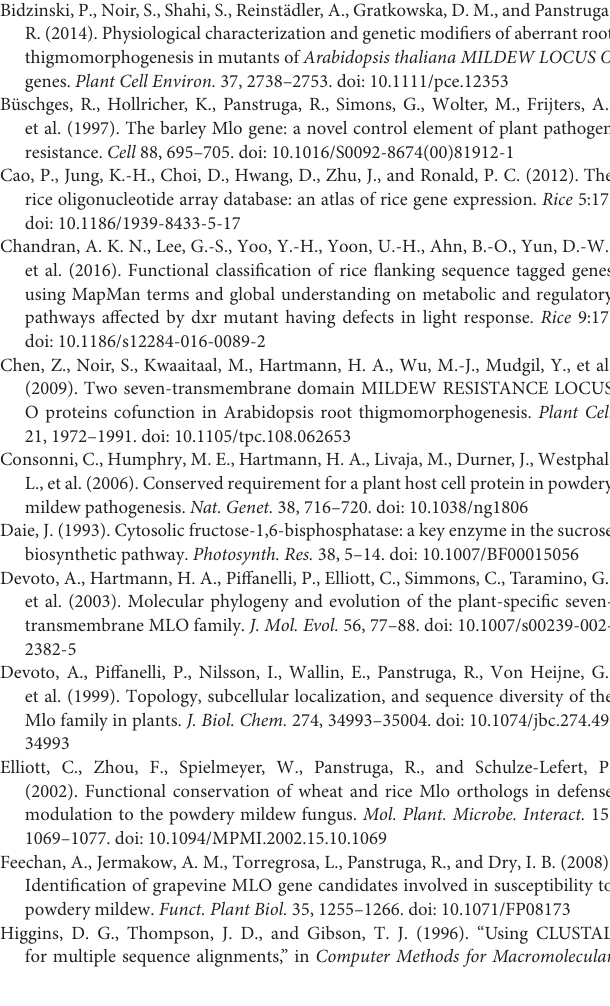
Figure S1 | Details of microarray data for OsMLO genes from anthers and pollen of indica and japonica rice cultivars. ACP, archespore; PMe, pre-meiotic; Me, meiotic; U, uninucleate stage; B, binucleate stage; T, trinucleate stage; FL, anther at flowering time; MP, mature pollen; GP, geminated pollen. Figure S2 | Agilent 44K data of OsMLO genes, including expression patterns in 13 tissues/organs. Log 2 intensities range from 5 (blue) to 15 (yellow). Figure S3 | Expression patterns based on Affymetrix arrays. Phylogenomic analysis of 12 OsMLO genes with integration of abiotic stress meta-data obtained in response to drought, salt, cold, heat, or submergence. Red boxes, genes up-regulated by stress treatment relative to control; green boxes, down-regulated by stress treatment; gray boxes, data not considered in microarray analysis.